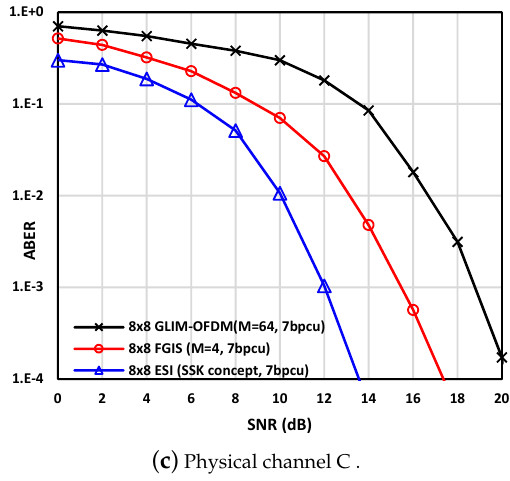
Figure 6. Scenario 2 test 2 ABER of the proposed ESI compared to GLIM [31] and FGIS [33] at the same MIMO-LEDs configurations, but with different modulation orders to achieve the same SE for three physical channels A, B, and